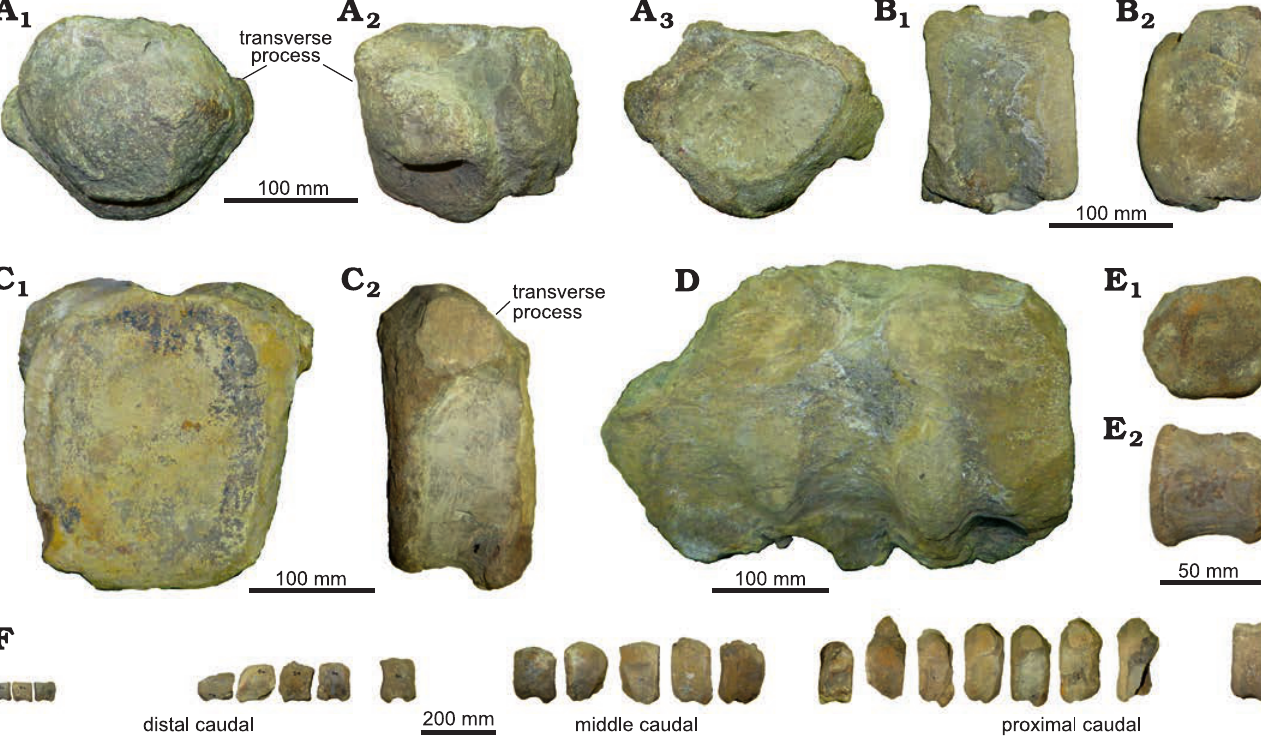
Fig. 4. Vertebrae of Lambeosaurinae indet.(FCBUANL_2711) from Ejido Presa San Antonio, Coahuila, Mexico, upper Campanian. A . Cervical vertebrae, in cranial (A 1 ), lateral (A 2 ), and caudal (A 3 ) views. B . Middle caudal vertebra, in lateral (B 1 ) and cranial (B 2 ) views. C . Proximal caudal vertebra, in cranial (C 1 ) and lateral (C 2 ) views. D . Sacrum in ventral view. E . Distal caudal vertebra in cranial (E 2 ) and lateral (E 2 ) views. F . Caudal vertebrae in lateral